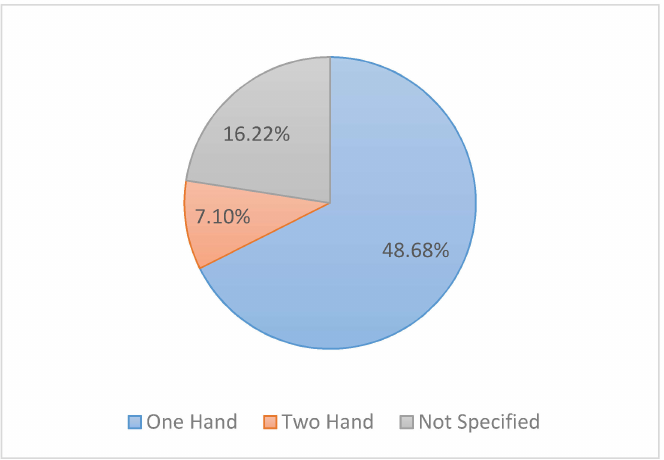
Figure 26. Number of articles for gesture recognition based on the number of